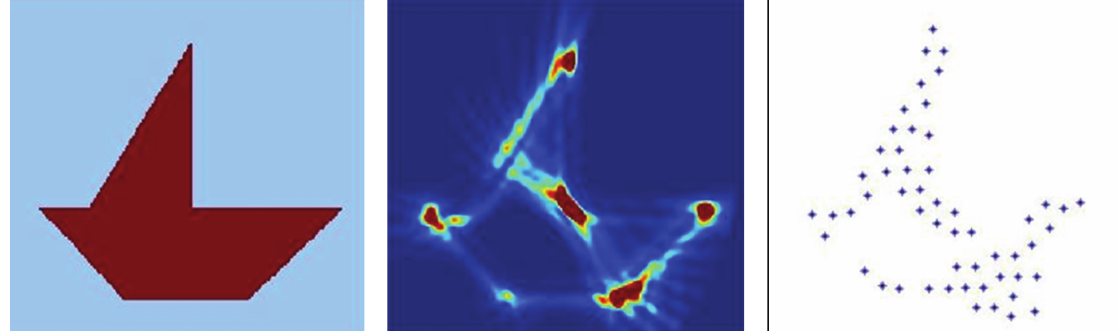
Figure 5: The original (a), SAR-processed (b), and scattering centers (c) images of a PEC object with a complex geometry.